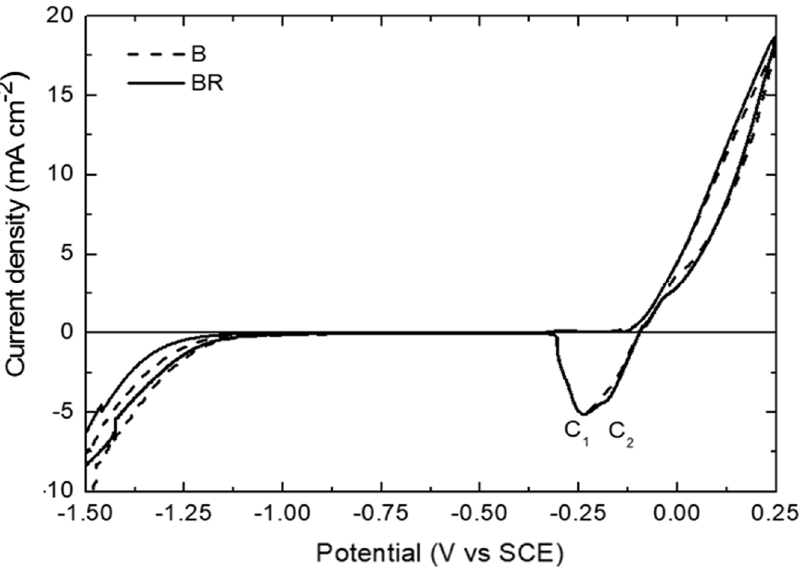
Figure 7. Cyclic voltammogram (from − 1.5 to 0.25 V vs SCE) in 3.5 wt.% NaCl at a 1 mV s − 1 scan rate for B (as cast) and BR (annealed)